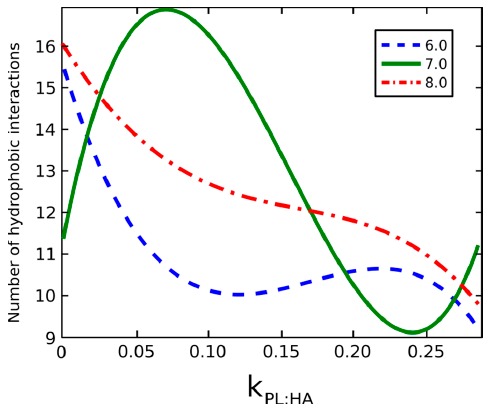
Figure 13. The total number of hydrophobic interactions inside HA. The legend indicates pH values.